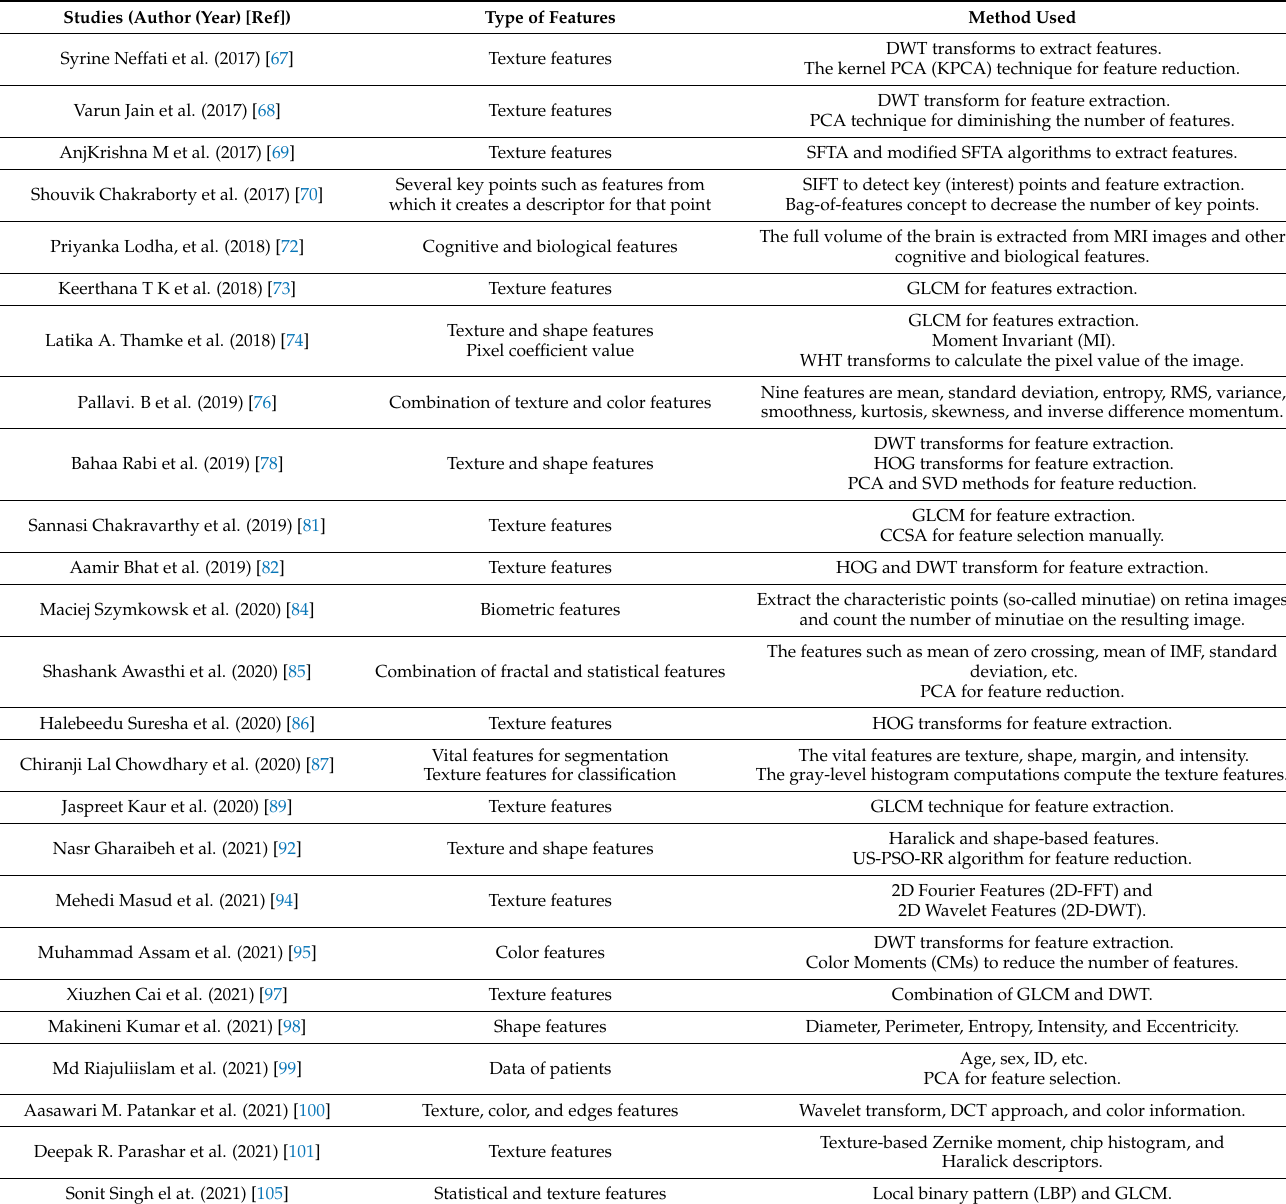
Table 2. Distribution of studies for different feature extraction